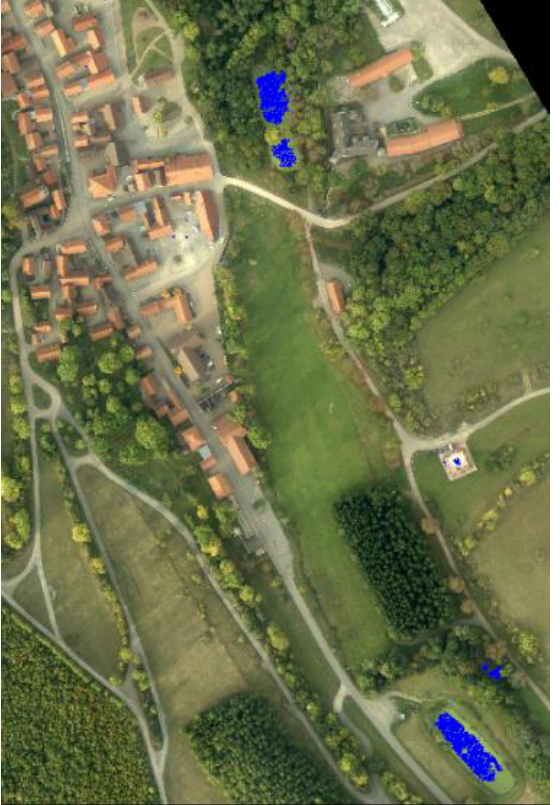
Figure 8: Orthoimage and classified water surfaces (blue) considering height variation and intensity variation